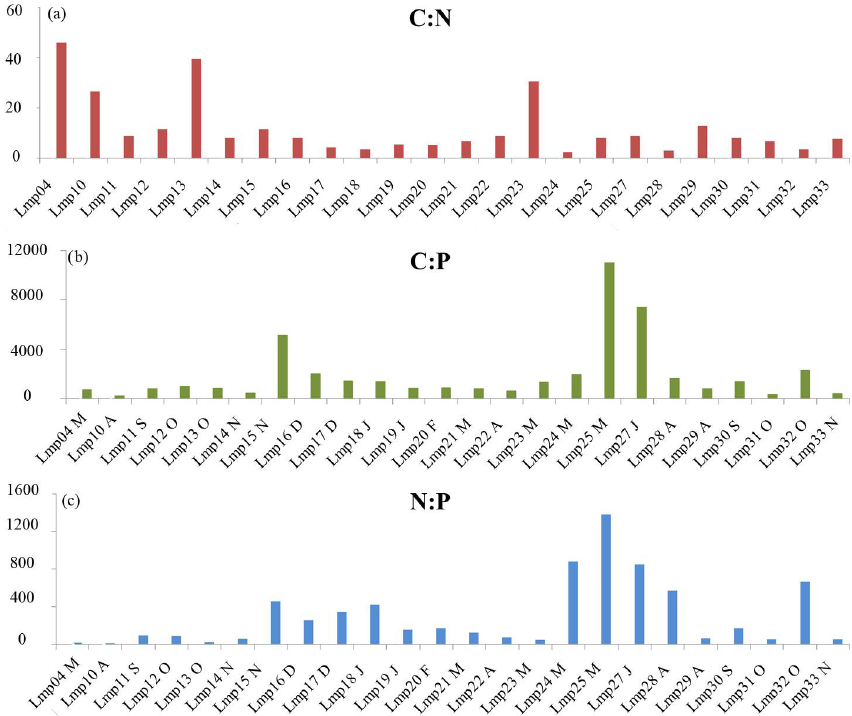
Figure 5. Temporal evolution of C:N (a) , C:P (b) , and N:P (c) ratios in atmospheric deposition samples. The sample name and the initials of each month (from March, Lmp04, to November, Lmp33) are reported on the x